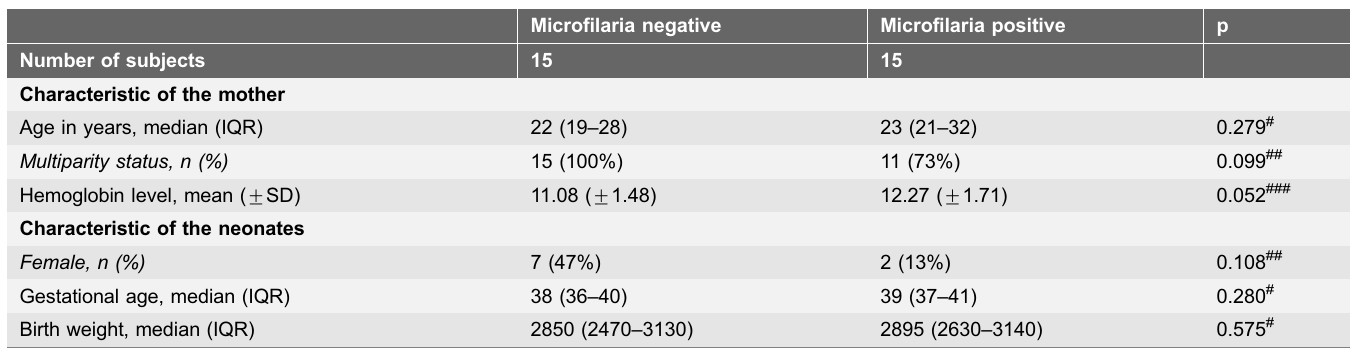
Table 2. Baseline characteristic of the mother and the children enrolled in the